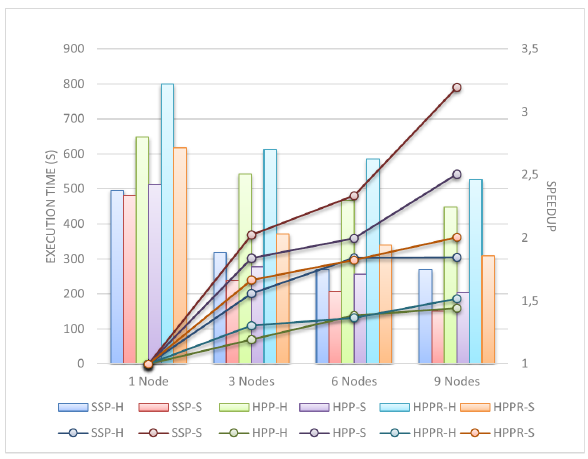
Figure 2. Segmentation of the 4K image.